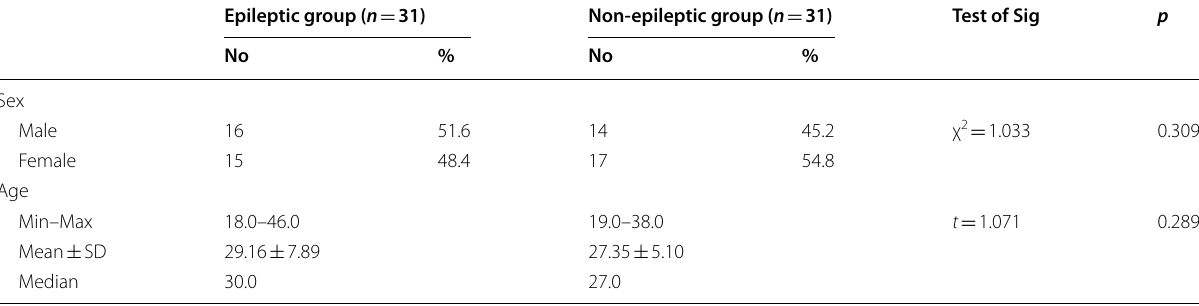
Table 1 Patients’ demographics